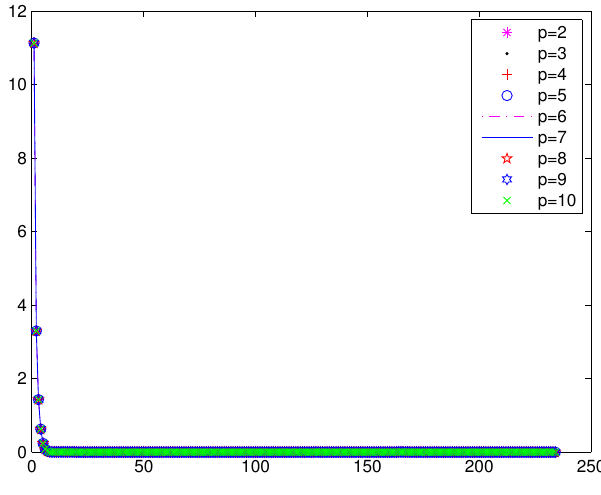
Figure 4. Numerical results for Example 2 by the STRM method. The x -axis represents the iteration (cid:107) F ( x , y ) (cid:107) 2 . step; the y -axis represents θ ( x , y ) = 1 2